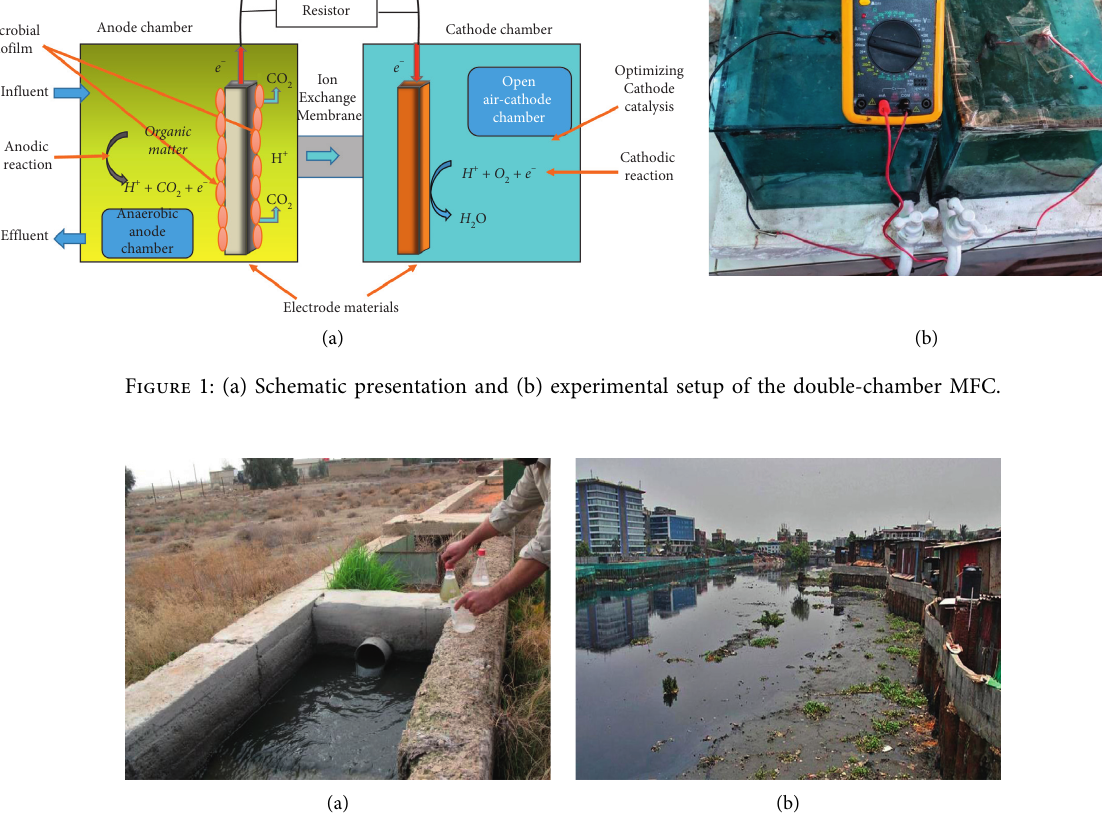
Figure 2: Sources of wastewater used as electrolytes: (a) municipal drain; (b) Bhairab